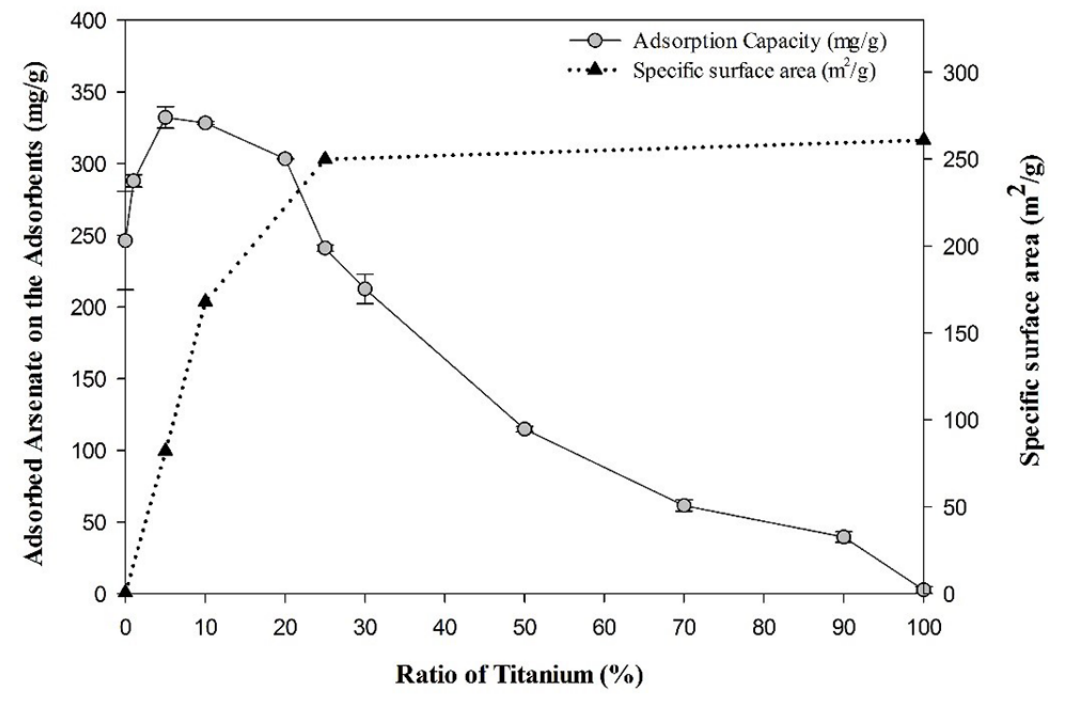
Figure 2. Synergistic effect of arsenate adsorption by Ti-loaded BYC in accordance with the variation of titanium ratio in BYC (Initial concentration of arsenate: 1000 mg/L; pH: 7; Reaction time: 24 h; Temperature: 298K; titanium ratio: atomic